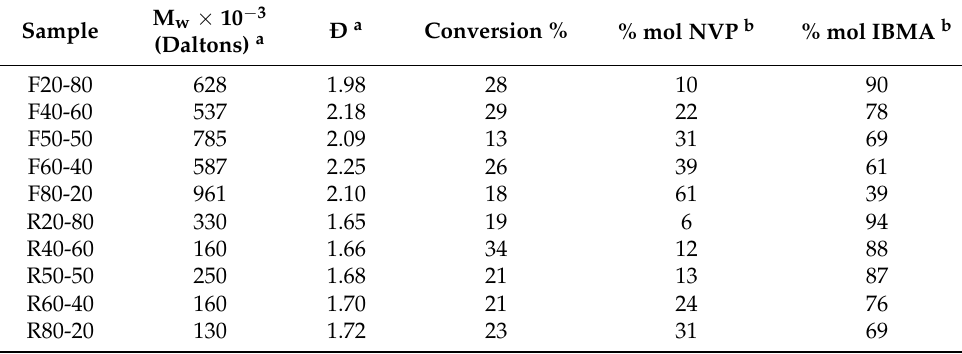
Table 1. Molecular characteristics of the PNVP-stat-PIBMA